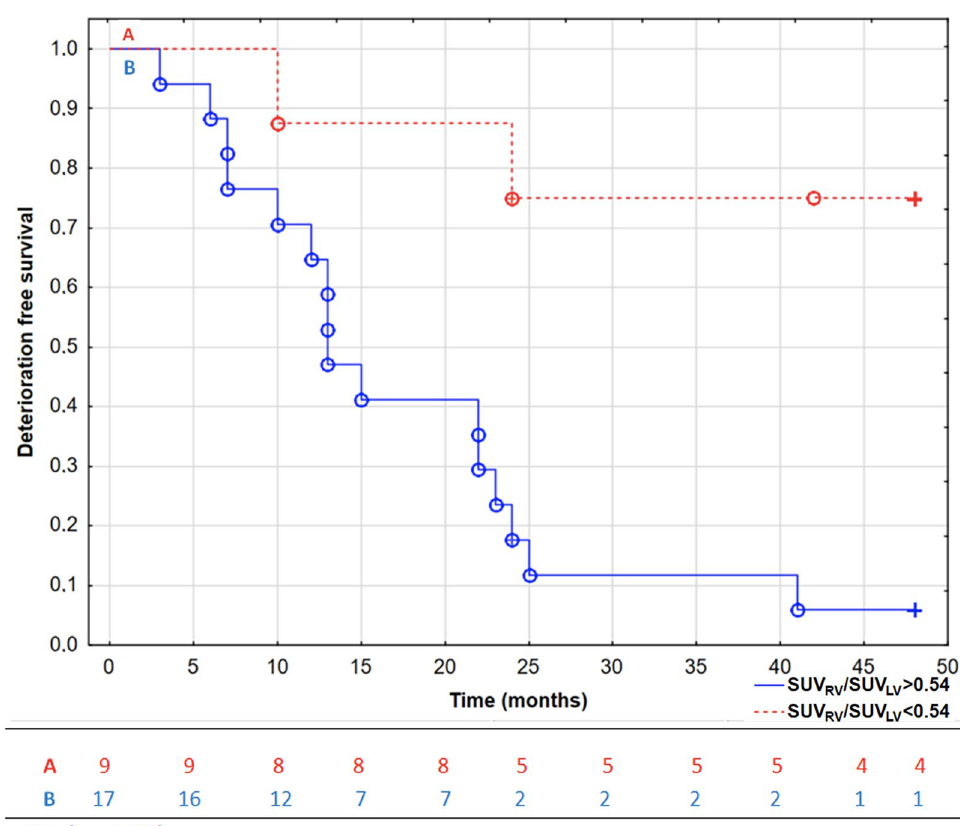
Fig. 3 Kaplan–Meier curves presenting deterioration-free survival in patients with pulmonary arterial hypertension based on SUV RV /SUV LV ratio in 48 months of observation, log-rank test, p 0.0007. °, complete events; , censored events; LV Left ventricle, RV Right ventricle, SUV Standardized = + uptake